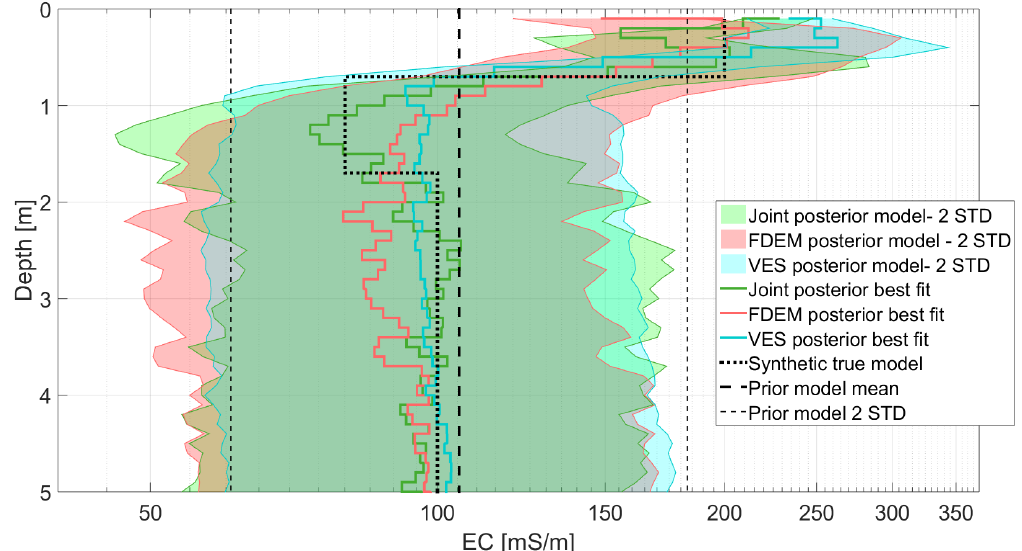
Figure 3. Kalman ensemble generator (KEG) inversion results for the same synthetic true model using the same prior model for vertical electrical sounding (VES) data, frequency domain electromagnetic (FDEM) data, and joint inversion of VES and FDEM data.